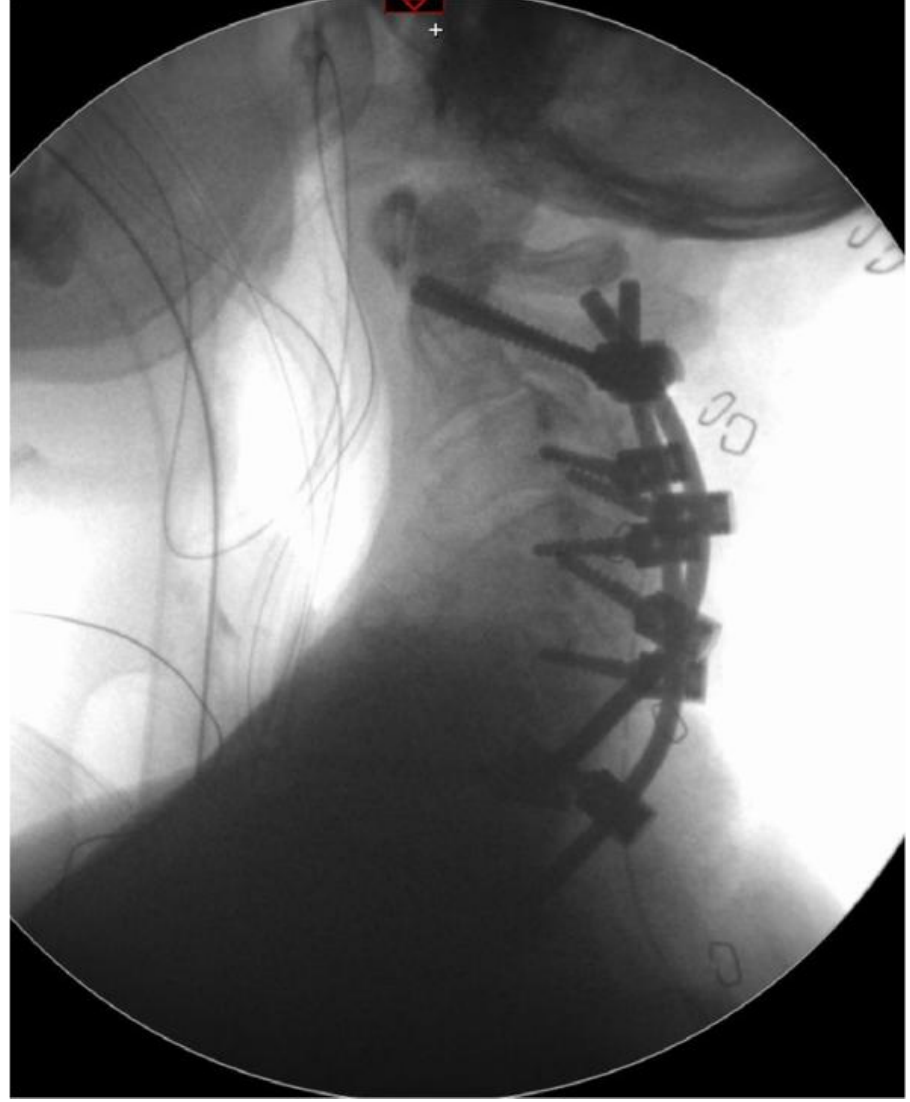
Figure 7. Post ‐ operative radiological examination. Figure 7. Post-operative radiological